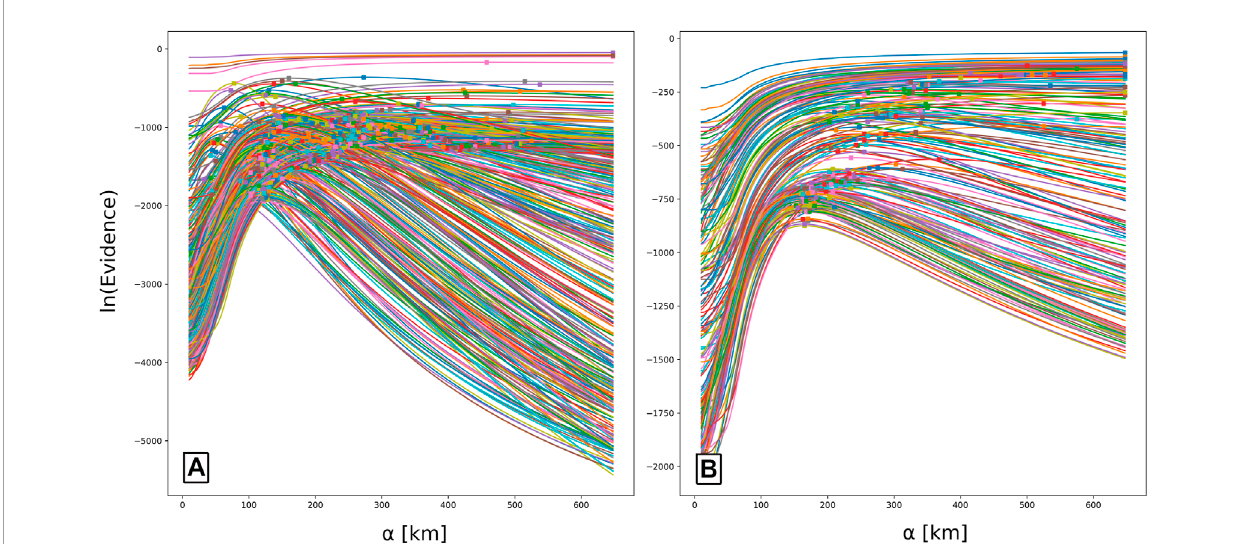
FIGURE 5 Evidence values for the least squares solution at each GNSS station (colored lines) for the range of values of α . Colored squares represent the α value that maximizes the evidence for each station. Dataset period pre-2014 (A) and dataset period 2018–2021 (B) .